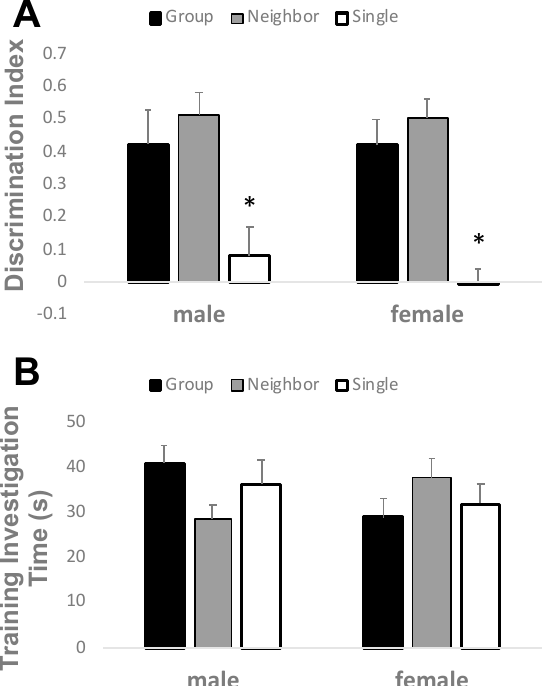
Figure 4. Neighbor housing rescued cognitive deficits in novel object recognition memory. ( A ) Using a 5 min inter-trial interval, single housed mice had a lower discrimination index as compared to group and neighbor housed mice. ( B ) Total investigation time during training did not differ between groups or sex. * p < 0.001 by two-way ANOVA for main effect of housing.